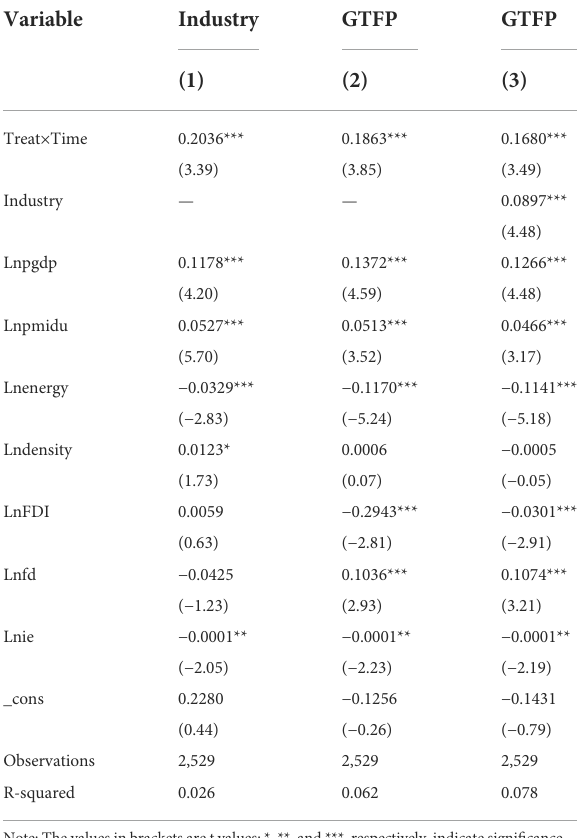
TABLE 5 Transmission mechanism of industrial upgrading